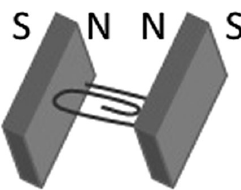
FIG. 4. The experiment performed by Dr.